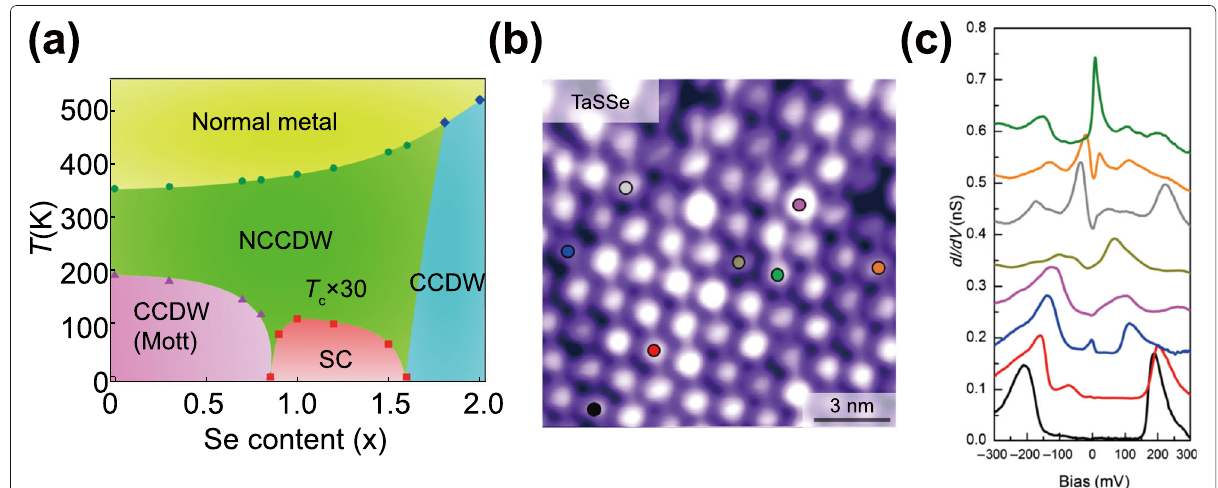
Fig. 7 Se-doping effects in 1 T -TaS 2 . a Electronic phase diagram of 1 T -TaS 2 − x Se x . b Topography acquired on the 1 T -TaS 2 − x Se x sample with the averaged Se concentration x = 1. c Local STM dI / dV spectra measured at various locations on the surface as marked in b . Taken from ref. [40,